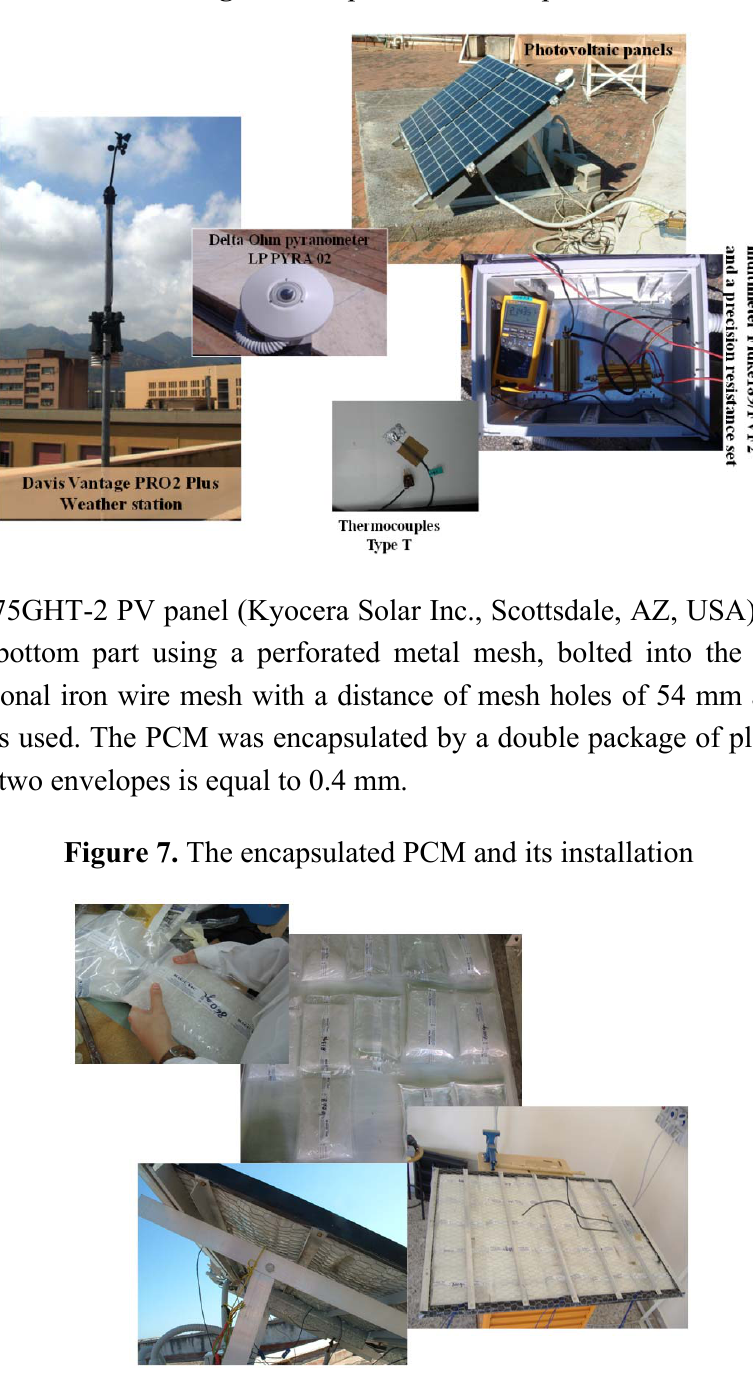
Figure 6. Experimental set-up.